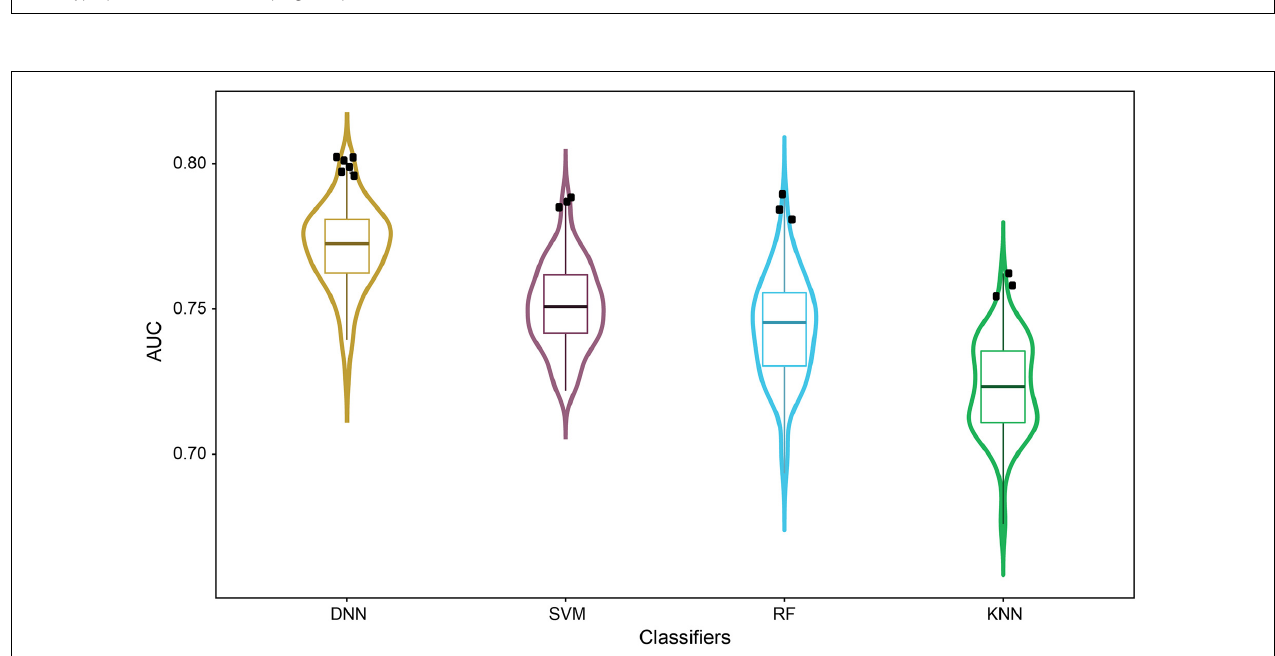
FIGURE 3 | Performance comparison based on MCCV results: the distributions of AUC scores were plotted based on 100-iteration MCCV results of DNN, SVM, RF and KNN in a violin box style. DNN models distributed around 1.5 × interquartile range of violin plot were highlighted in black dots.